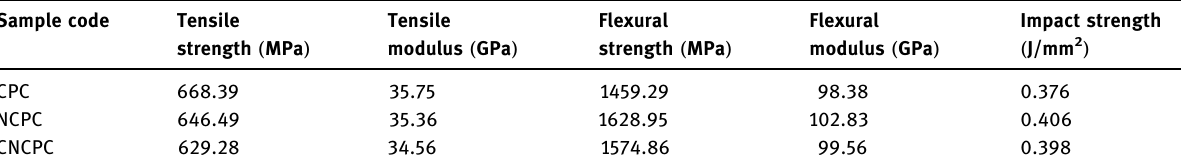
Table 1: Mechanical properties of CPC, NCPC, and CNCPC composites Sample